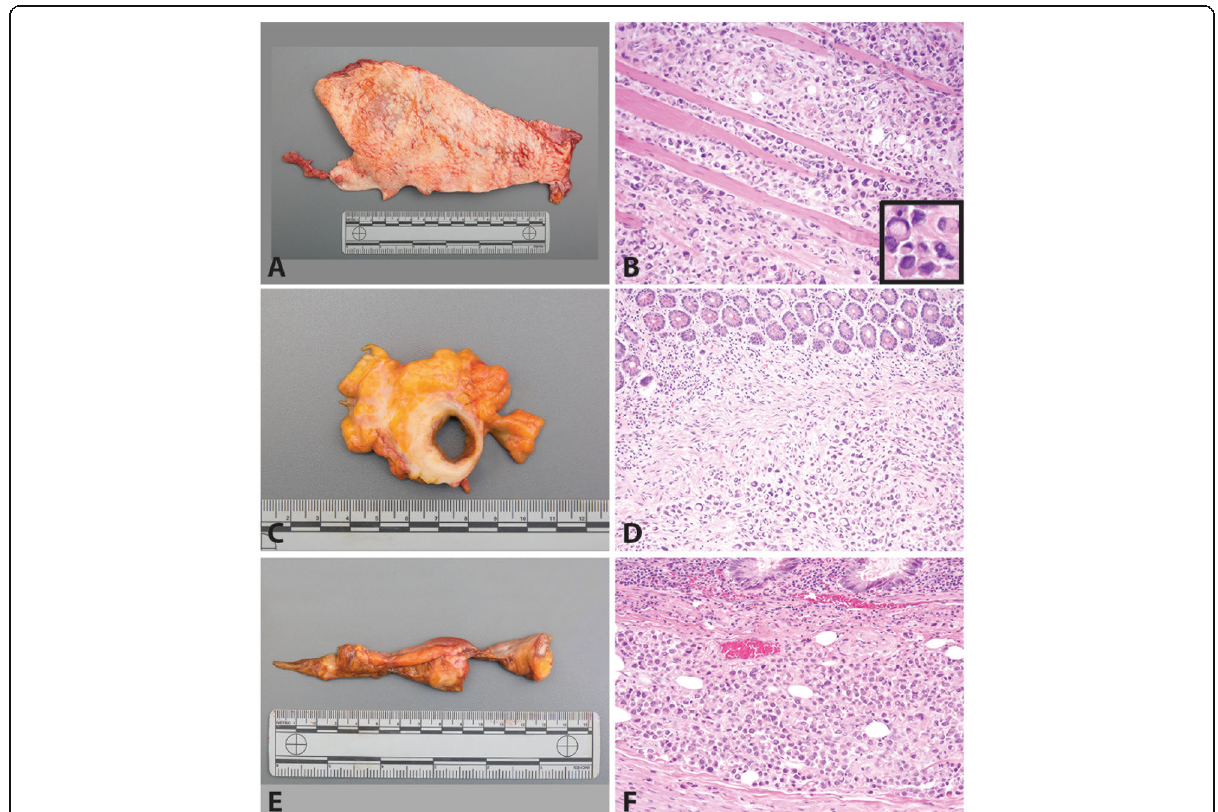
Fig. 2 Plasmacytoid Urothelial Carcinoma in the Abdomen. The abdominal wall and peritoneum were grossly thickened with a white plaque ( a ). The skeletal muscle of the right abdominal wall was diffusely infiltrated by plasmacytoid tumor cells ( b ) [H&E 200x; inset 400x]. The lower gastrointestinal tract was diffusely involved with tumor encasing the ileum ( c ) with involvement of the submucosa ( d ) [H&E 200x] and the appendix ( e ) with tumor extending into the muscularis ( f ) [H&E 200x]. Tumor was present throughout the abdomen in the omentum, gallbladder, colon and rectum. Extra-abdominal metastases were present in the lungs, pleura, diaphragm and lymph nodes (not